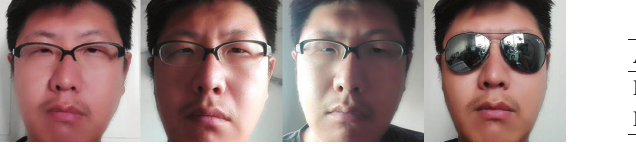
Figure 6: The samples of our database.